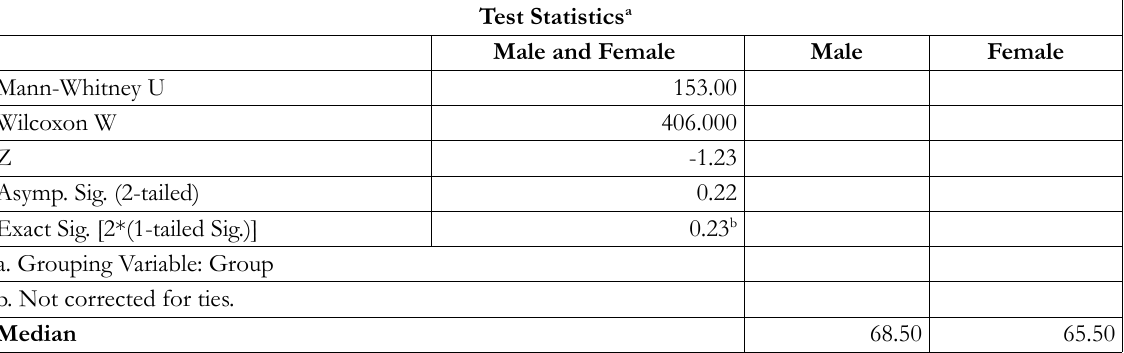
Table 6. A Mann Whitney U-test on the males and females’ posttest performance in EG